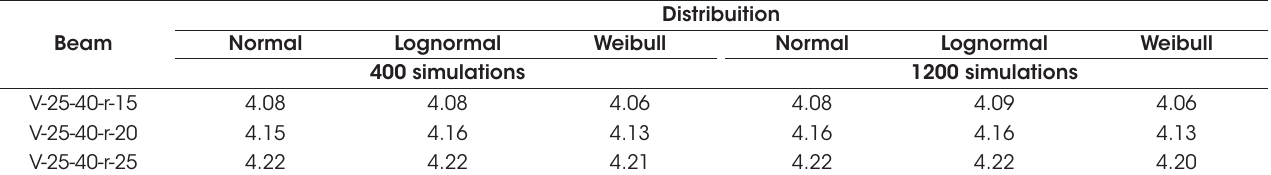
Values of β as a function of the probability distribution adopted and number of simulations Beam